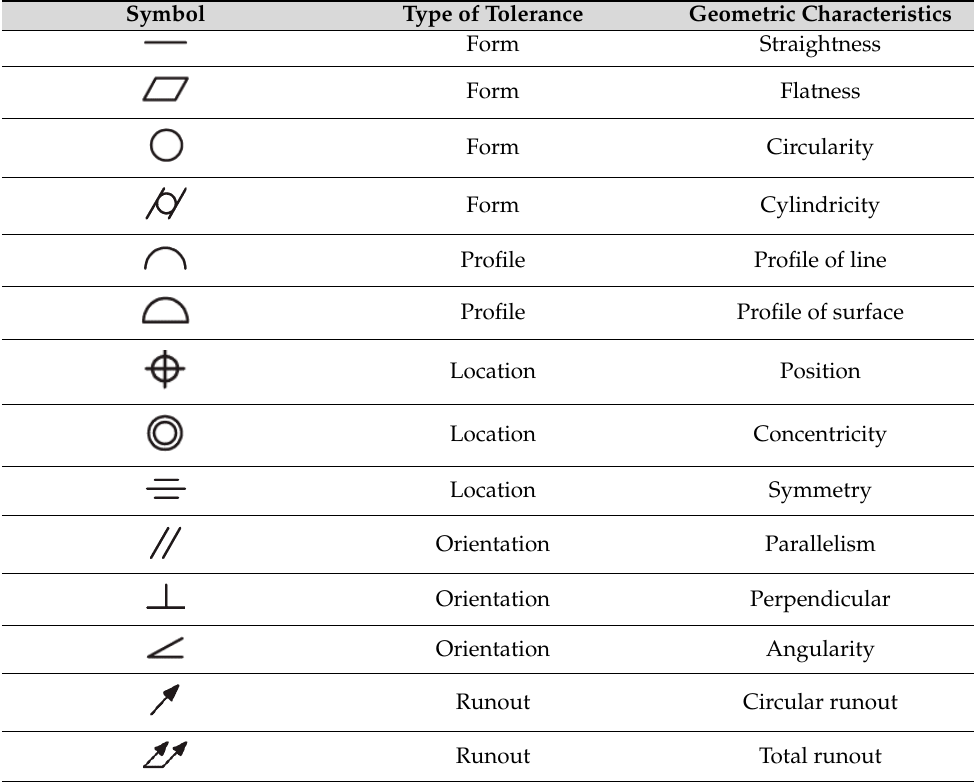
Table 1. Example symbol used in standard technical drawing.